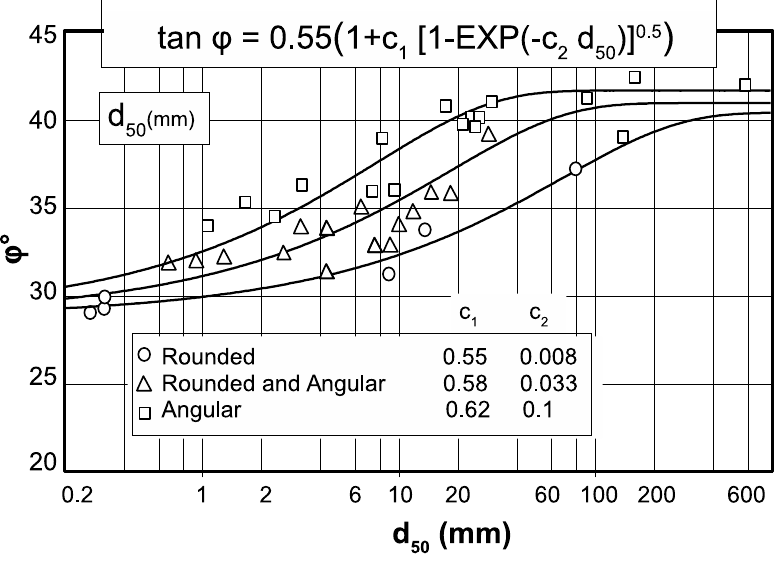
Figure 4. Estimation of static angle of repose, by curve fit. (Data from Simons